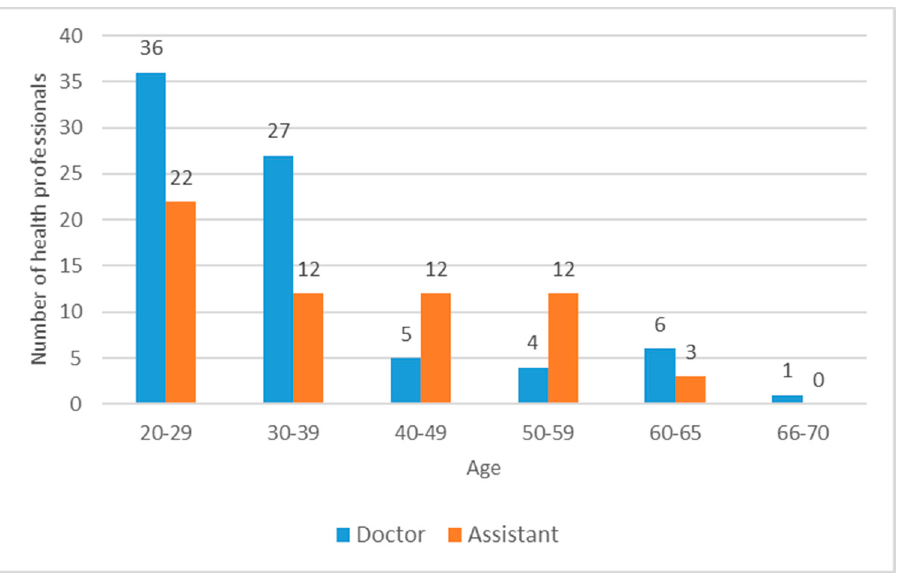
Figure 4. Age distribution of health professionals of the Department of Community Dentistry of Semmelweis University as of 11 March 2020.